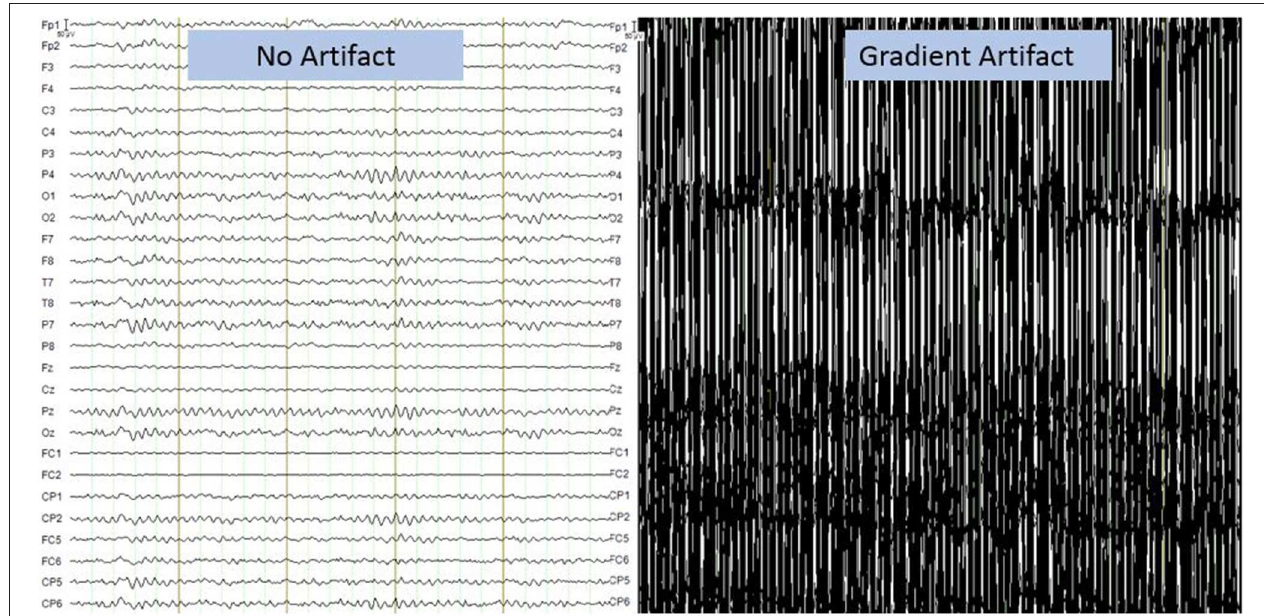
FIGURE 2 | Gradient artifact on electroencephalographic recording. It presents a broadband artifact covering the entire spectrum of EEG frequencies. The amplitude of the artifact is more than 1,000 times that of the EEG signal. Image obtained on a 40 years-old healthy volunteer with hybrid EEG-fMRI system and included for illustrative purpose